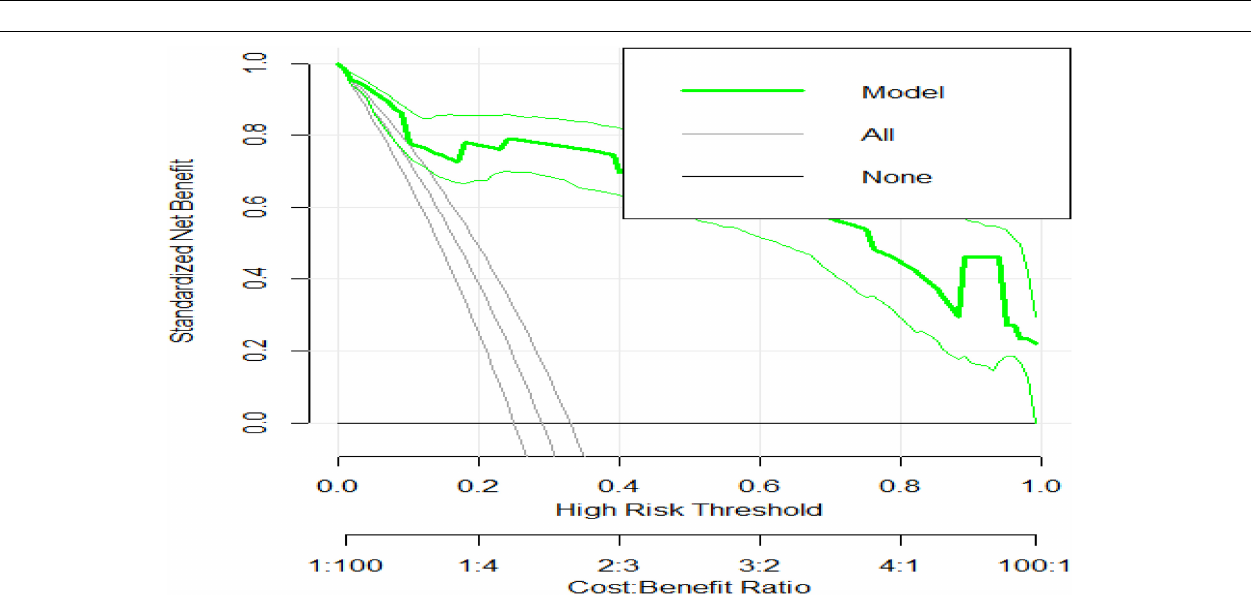
FIGURE 2 | Decision curve analysis for prediction of preterm neonates’